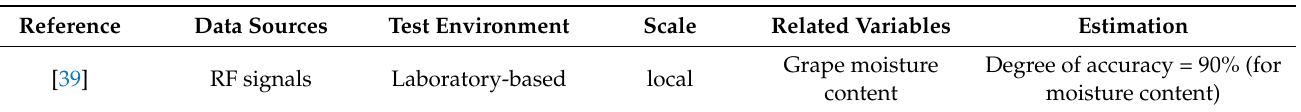
Table 9. Summary of records included in the systematic review (H—data-driven models based on radio frequency data